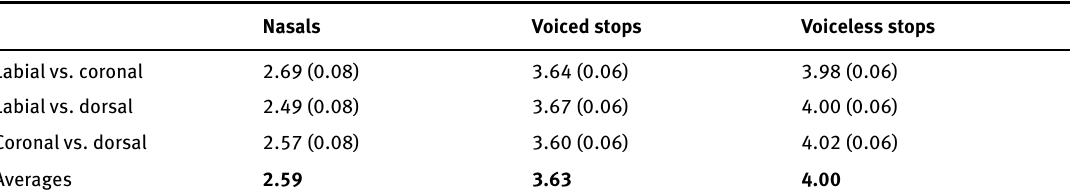
Table 1: The average similarity ratings in Experiment I (margins of errors for 95% confidence intervals). The lower the value, the more similar the